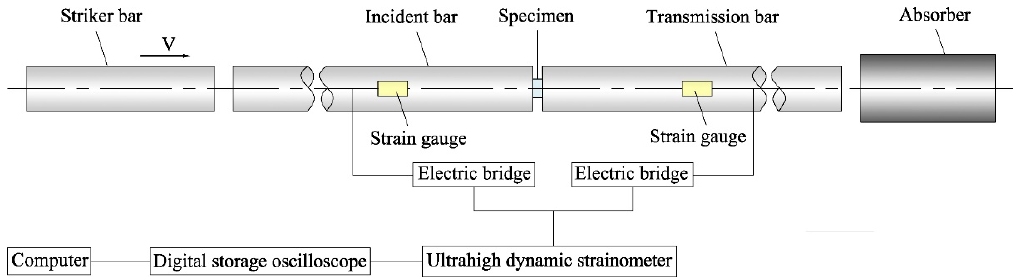
Figure 4. Schematic diagram of the split Hopkinson pressure bar apparatus.